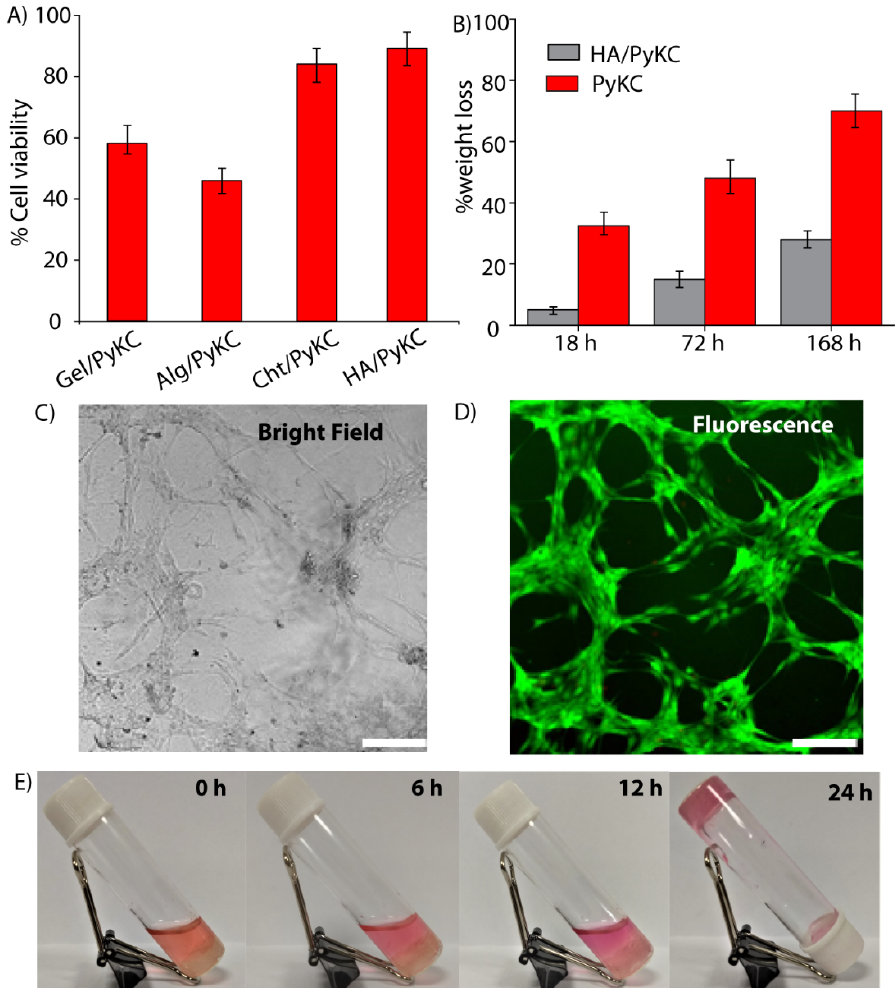
Figure 5. Cytocompatibility and stability of the composite hydrogels. ( A ) Cytotoxicity profile of different composite hydrogels toward MC3 T3-E1 preosteoblast cells after 3 days (mean values ± SD; n = 9). Statistics: Mann–Whitney U test p < 0.01). ( B ) Stability of the HA/PyKC and PyKC hydrogels against proteinase K digestion. ( C ) Bright field image of MC3 T3-E1 cells on Hyaluronic acid/PyKC composite hydrogel. Scale bar = 100 µ m ( D ) Fluorescence spectroscopic image of live MC3 T3-E1 cells on Hyaluronic acid/PyKC composite hydrogel. Scale bar = 100 µ m. ( E ) Photographs of HA/PyKC hydrogel incubated in α MEM for different time intervals demonstrating the stability of the composite hydrogel in the culture medium.